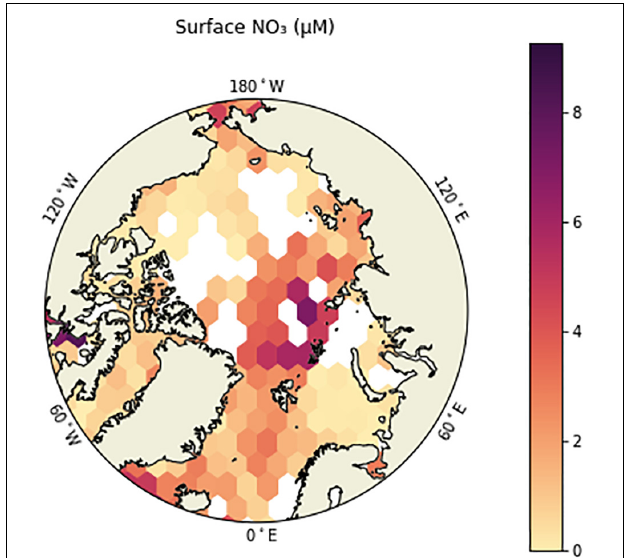
FIGURE 7 | Summer surface nitrate concentration.